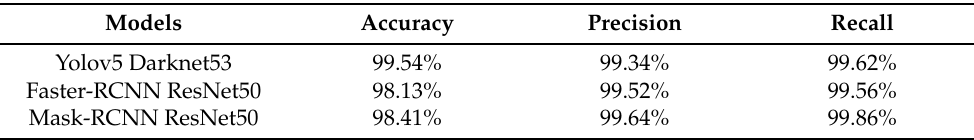
Table 1. Performances of Yolov5, Faster-RCNN and Mask-RCNN based on Baidu AI insect detection